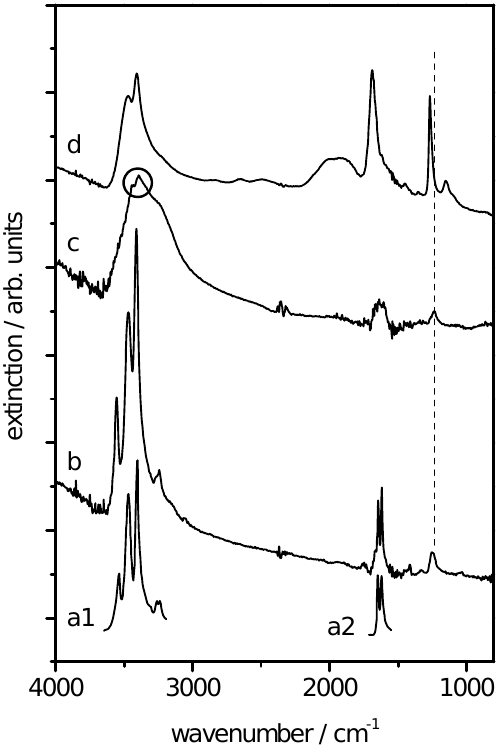
Fig. 9. Compilation of infrared spectra for various chemical species in the NaCl/OA/H 2 O system. Traces a1 and a2: Reference spec- tra of NaCl · 2H 2 O, obtained by digitising Fig. 1 from Schiffer and Hornig (1961). Trace b: Infrared extinction spectrum of effloresced NaCl · 2H 2 O/OA recorded after the second crystallisation period of Exp. 2b. Trace c: Infrared extinction spectrum of effloresced NaCl/OA particles in an external mixture with a small fraction of unfrozen NaCl/OA/H 2 O solution droplets, recorded at the end of the first crystallisation period of Exp. 2a (lowermost spectrum from the series shown in the right panel in Fig. 4). Trace d: Infrared ex- tinction spectrum of oxalic acid dihydrate crystals at 244K from the study by Wagner et al. (2010). The dashed vertical line denotes the position of the C–O stretching mode of oxalic acid at 1240cm − 1 in spectra b and c. See text for